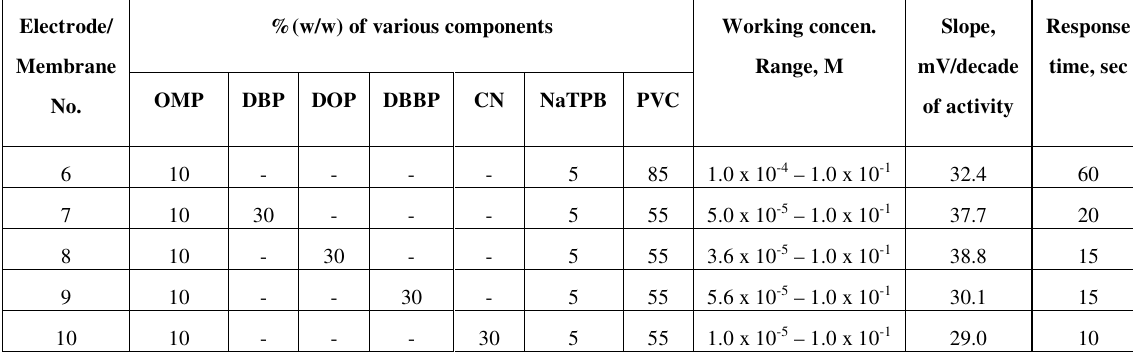
Table 2: Composition and response characteristics of PVC based OMP membranes selective for Ni 2+